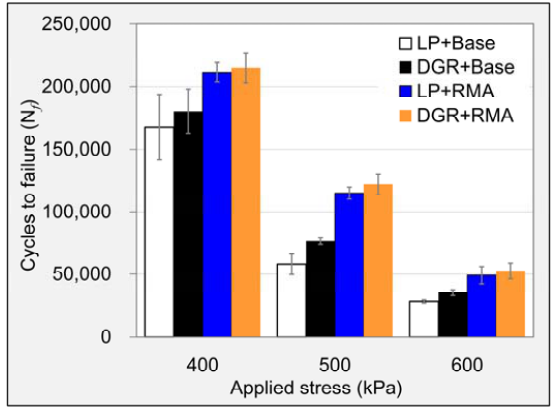
Figure 18. Fatigue life test results of different asphalt mixtures.